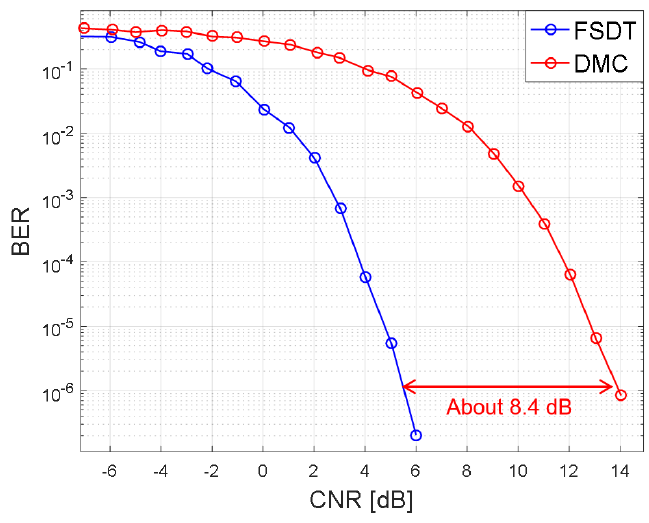
Figure 6. Bit error rate (BER) performance comparison between FSDT and differential Manchester coding (DMC).